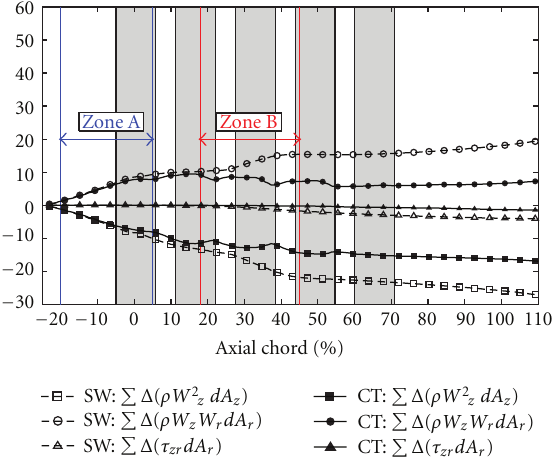
Figure 16: NASA Rotor 37 with and without CT: cumulative sum in the axial direction of the principal terms involved in the axial momentum